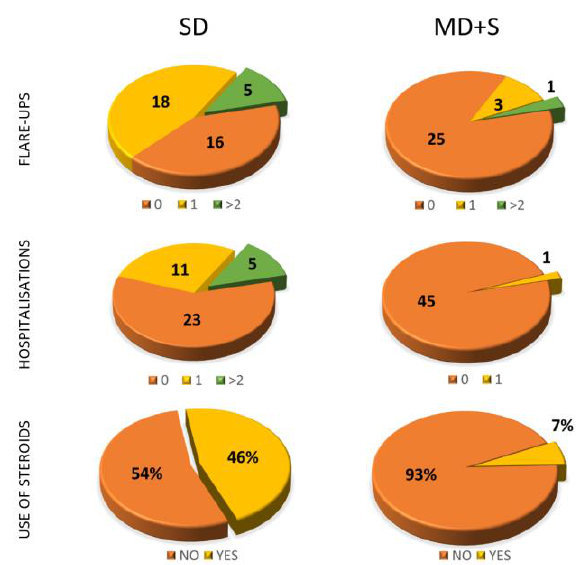
Figure 4. Results of the study of certain qualitative variables depending on vitamin D levels (SD or MD + S). MD+S).